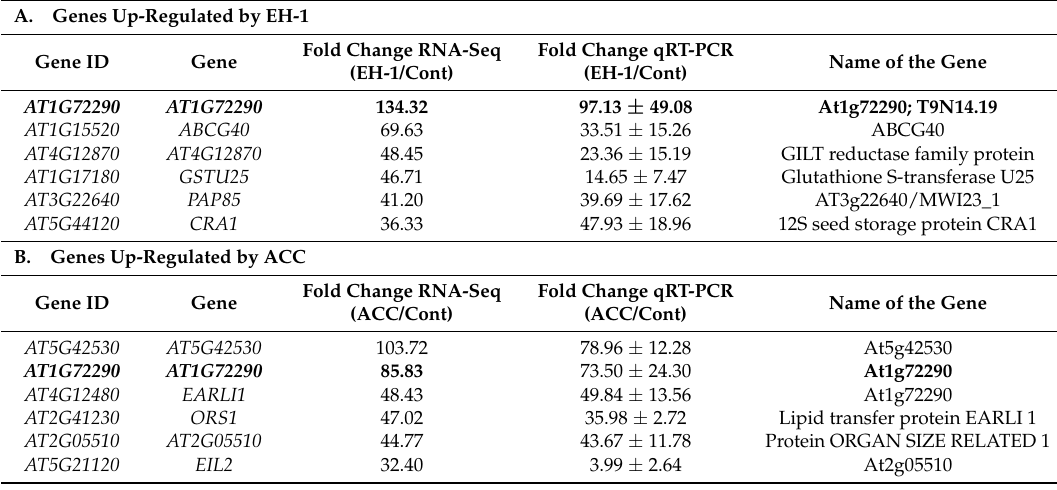
Table 2. RNA-Seq and qRT-PCR analysis of select genes up-regulated by EH-1 and/or